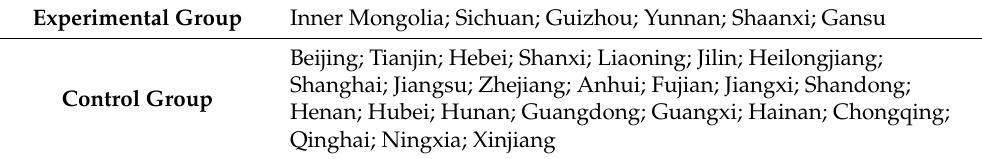
Table 8. Study sample. Experimental